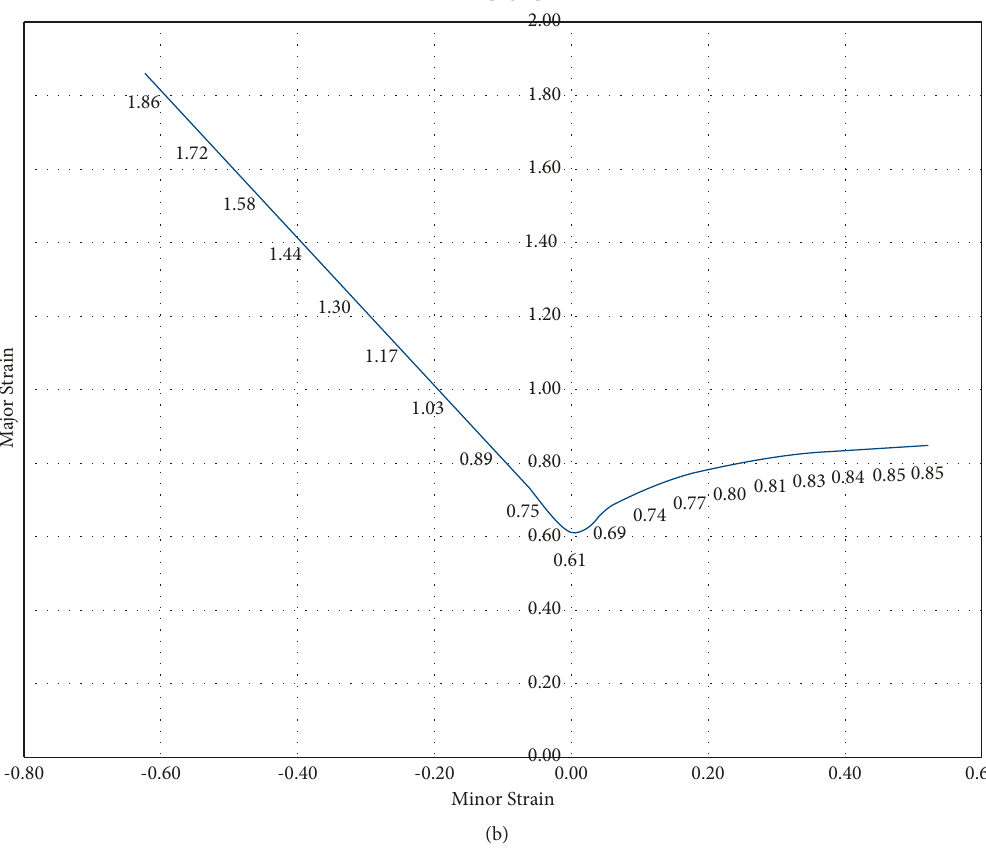
Figure 7: FLC of APA (a) and GPG (b).